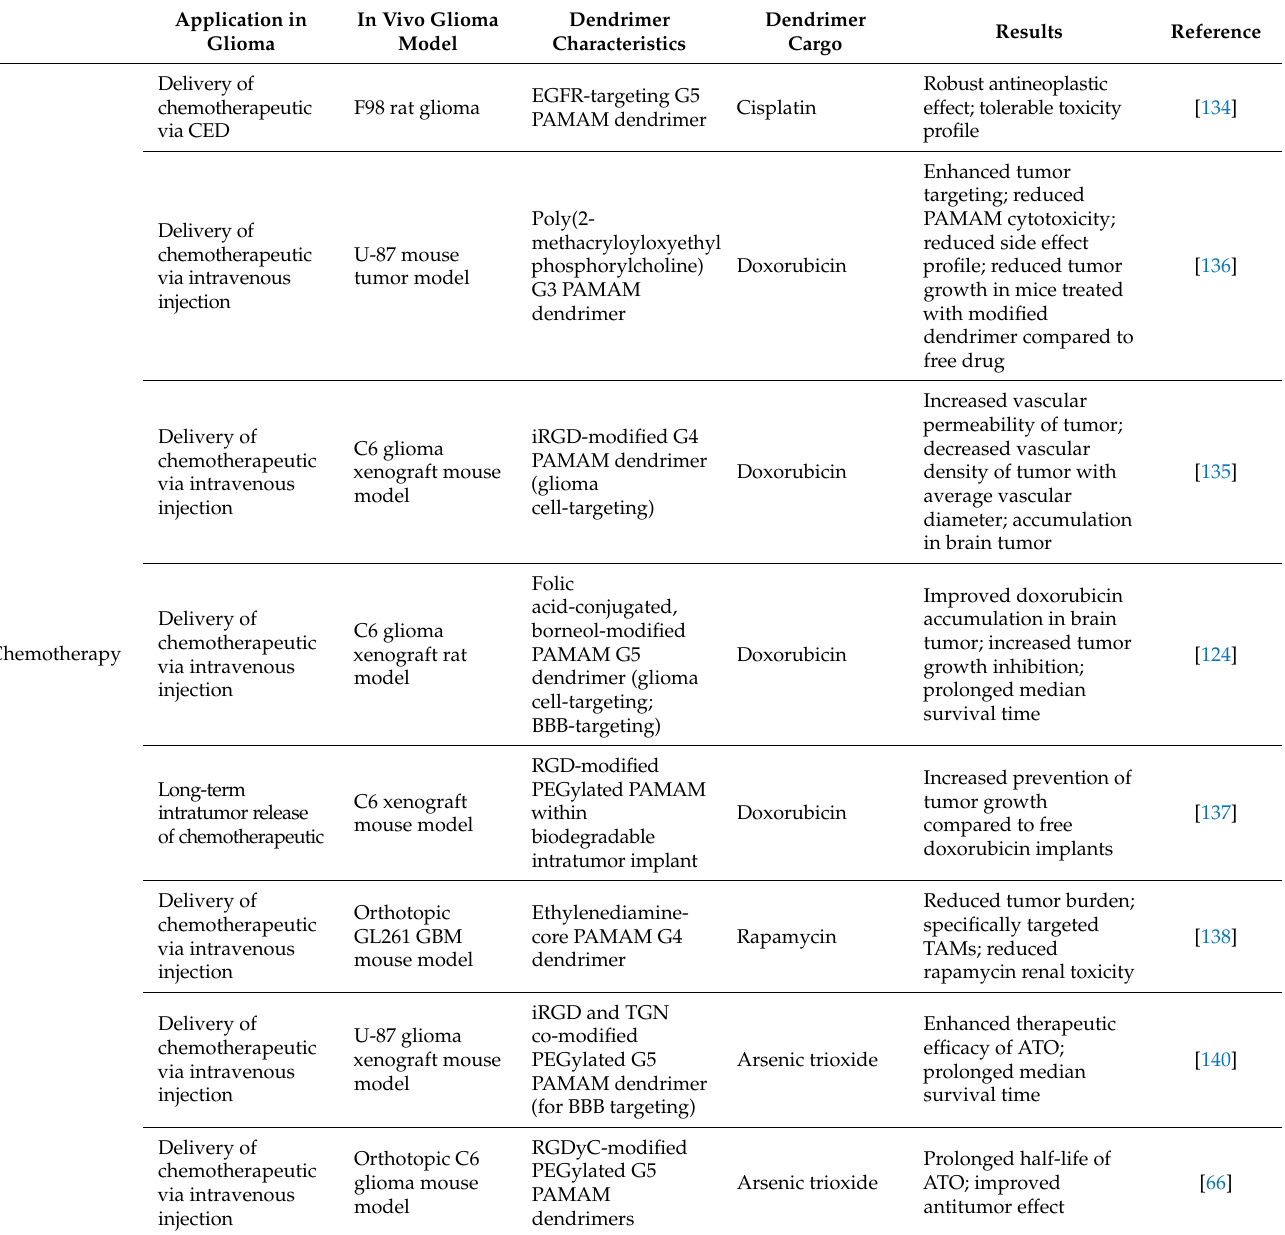
Table 1. Recent in vivo studies testing dendrimer applications in rodent models of